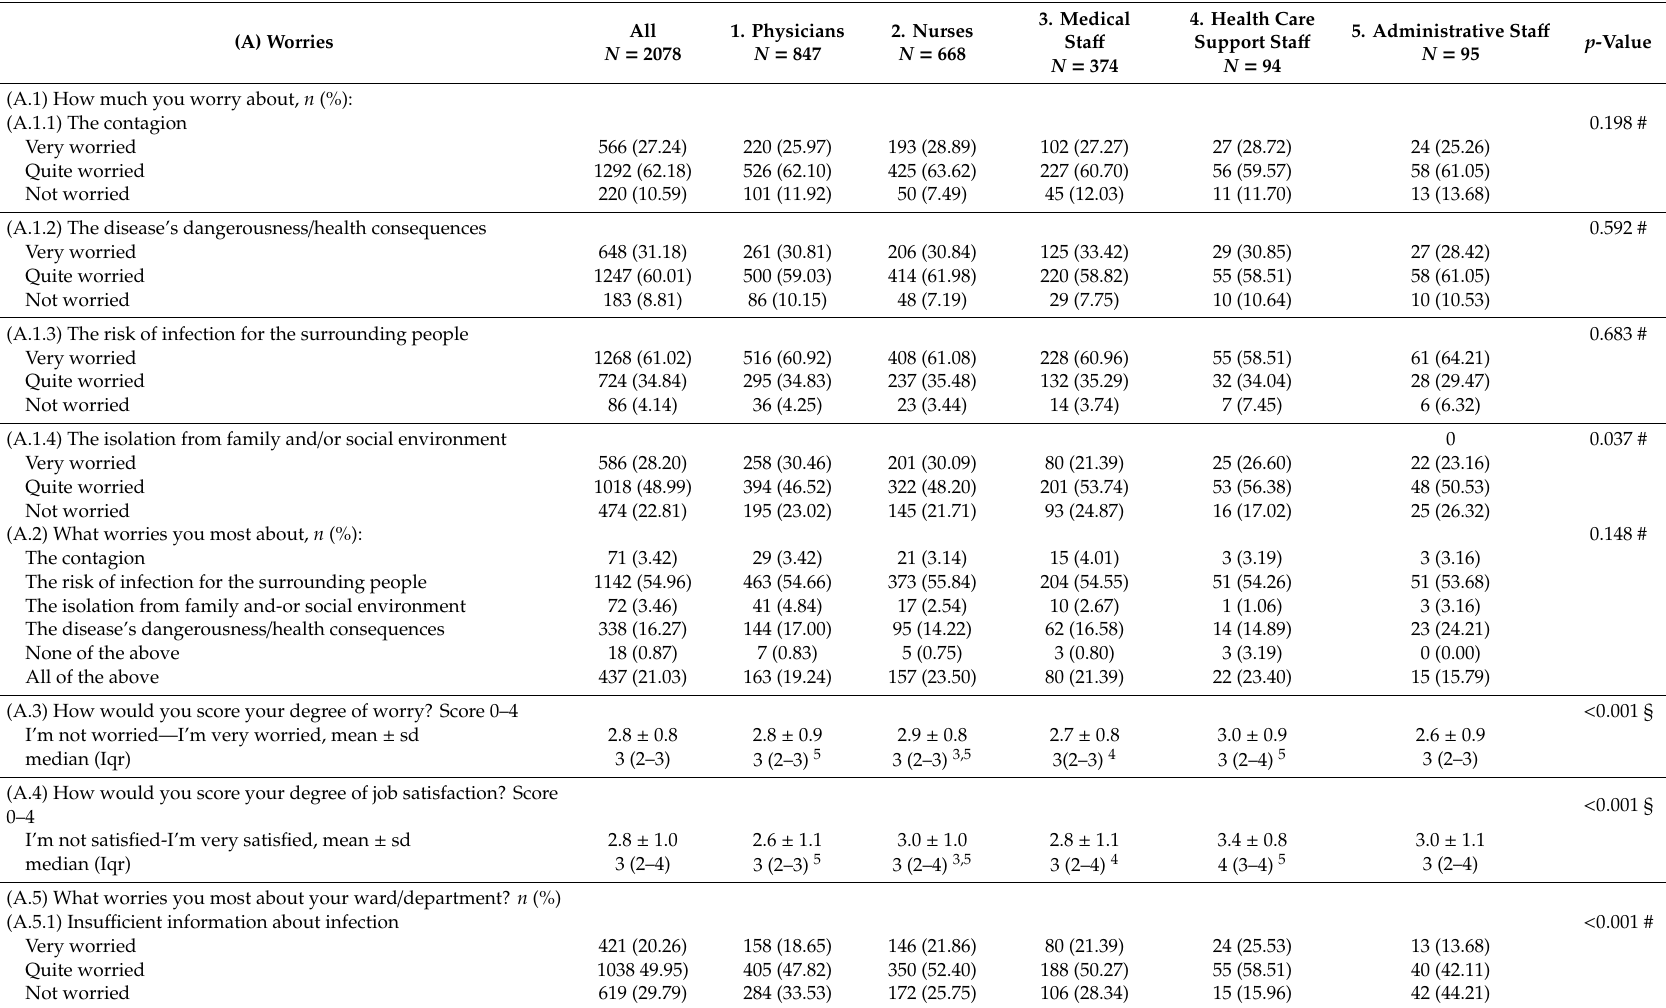
Table 2. Health care workers’ concerns and worries about COVID-19